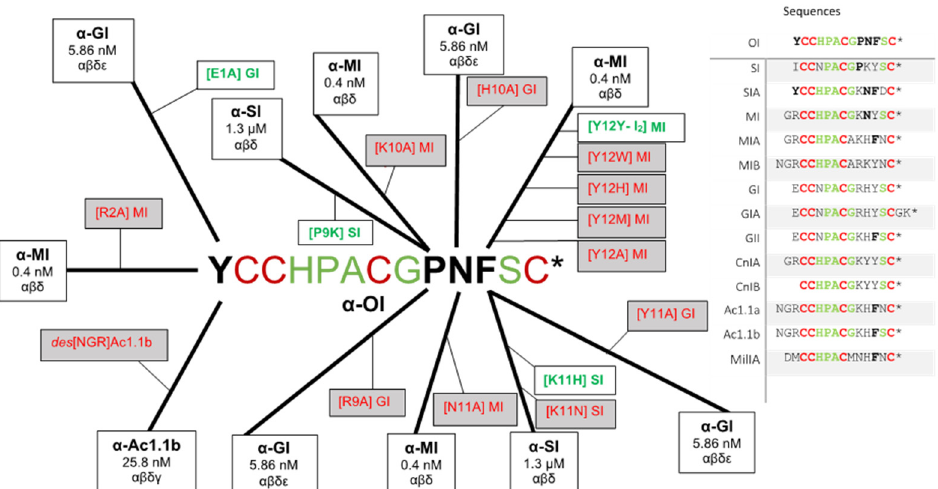
Figure 2. Site-specific mutational map of α 3/5 ′ s compared to α -conotoxin OI. Within the α -conotoxin OI peptide sequence, the bold amino acids ( αα ) represent variable positions, while the green αα are generally conserved (cysteines highlighted in red). The long branch signifies the parent α -conotoxin, while the shorter branch coming off the extended branch is the corresponding synthetic analog. A red analog indicates the mutated conotoxin’s half maximal effective concentration (IC 50 ) increased (less toxic), and a green analog indicates the mutated conotoxin’s IC 50 decreased (more toxic). The number within the α -conotoxin boxes indicates the observed IC 50 towards the αβδ isoform of the muscle nAChR. Sequences of illustrated α 3/5-conotoxins are provided, with regions of conserved αα presented. Asterisk (*) indicates the presence of a C -terminal amide.